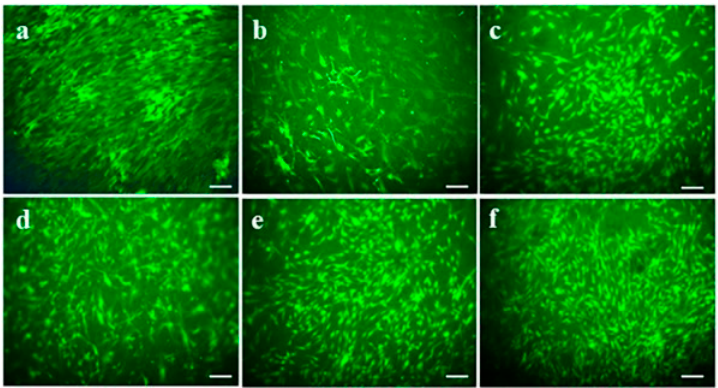
Figure 5. CMFDA live cell imaging of fibroblast on biocomposite nanofibrous scaffolds on day 6 ( a ) / AV, ( d ) PCL / CUR, ( e ) PCL / AV / CUR ( f ) PCL / AV / TCH. Scale Bar = 50 µ TCP, ( b ) PCL, ( c ) PCL/AV, ( d ) PCL/CUR, ( e ) PCL/AV/CUR ( f ) PCL/AV/TCH. Scale Bar = 50 µm. ( b ) PCL, ( c ) PCL